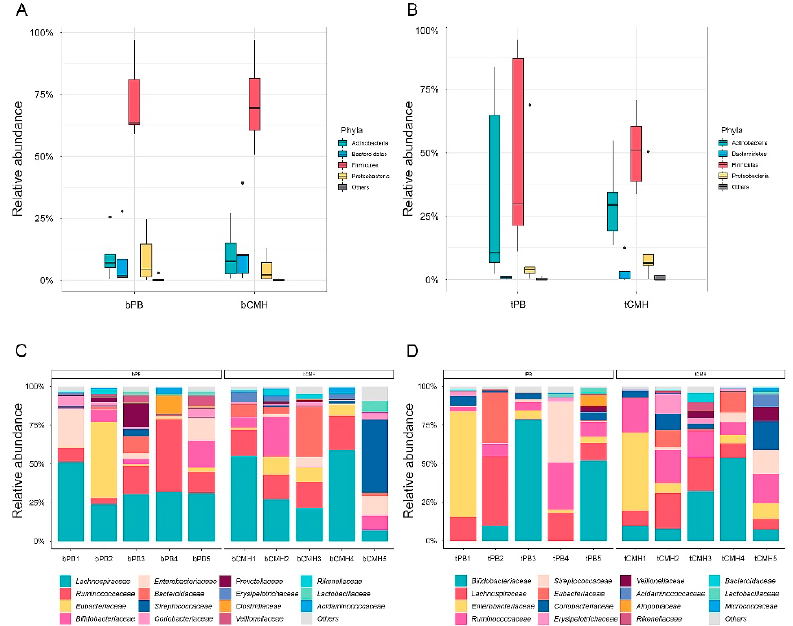
Figure 3. Taxonomic profiles of gut microbiome using WMGS datasets. ( A , B ) Boxplot of relative abundance of microbial phyla across baselines and treatments, respectively. ( C , D ) Stacked column graph showing the relative abundance of taxonomic families across baselines and treatments, re- spectively. In addition, bPB, bCMH, tPB, and tCMH represent baseline placebo, baseline CMH, treatment with placebo, and treatment with CMH, respectively.